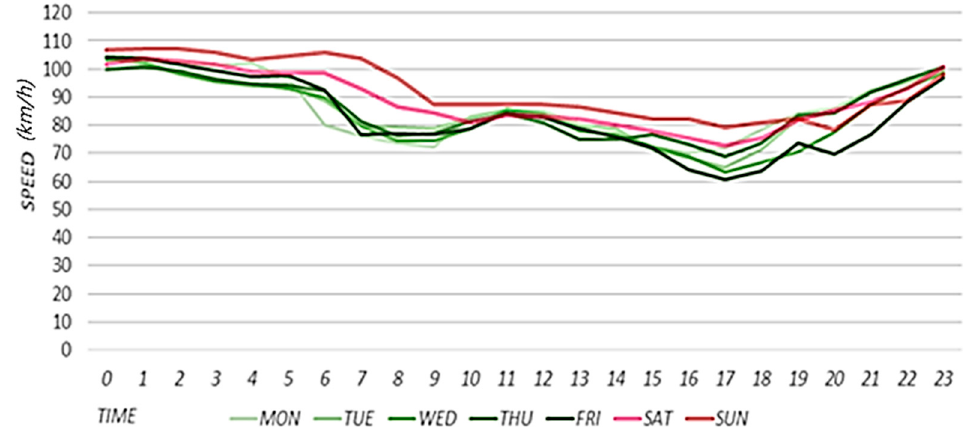
Figure 7. Results of calculating the average speed of the target road.